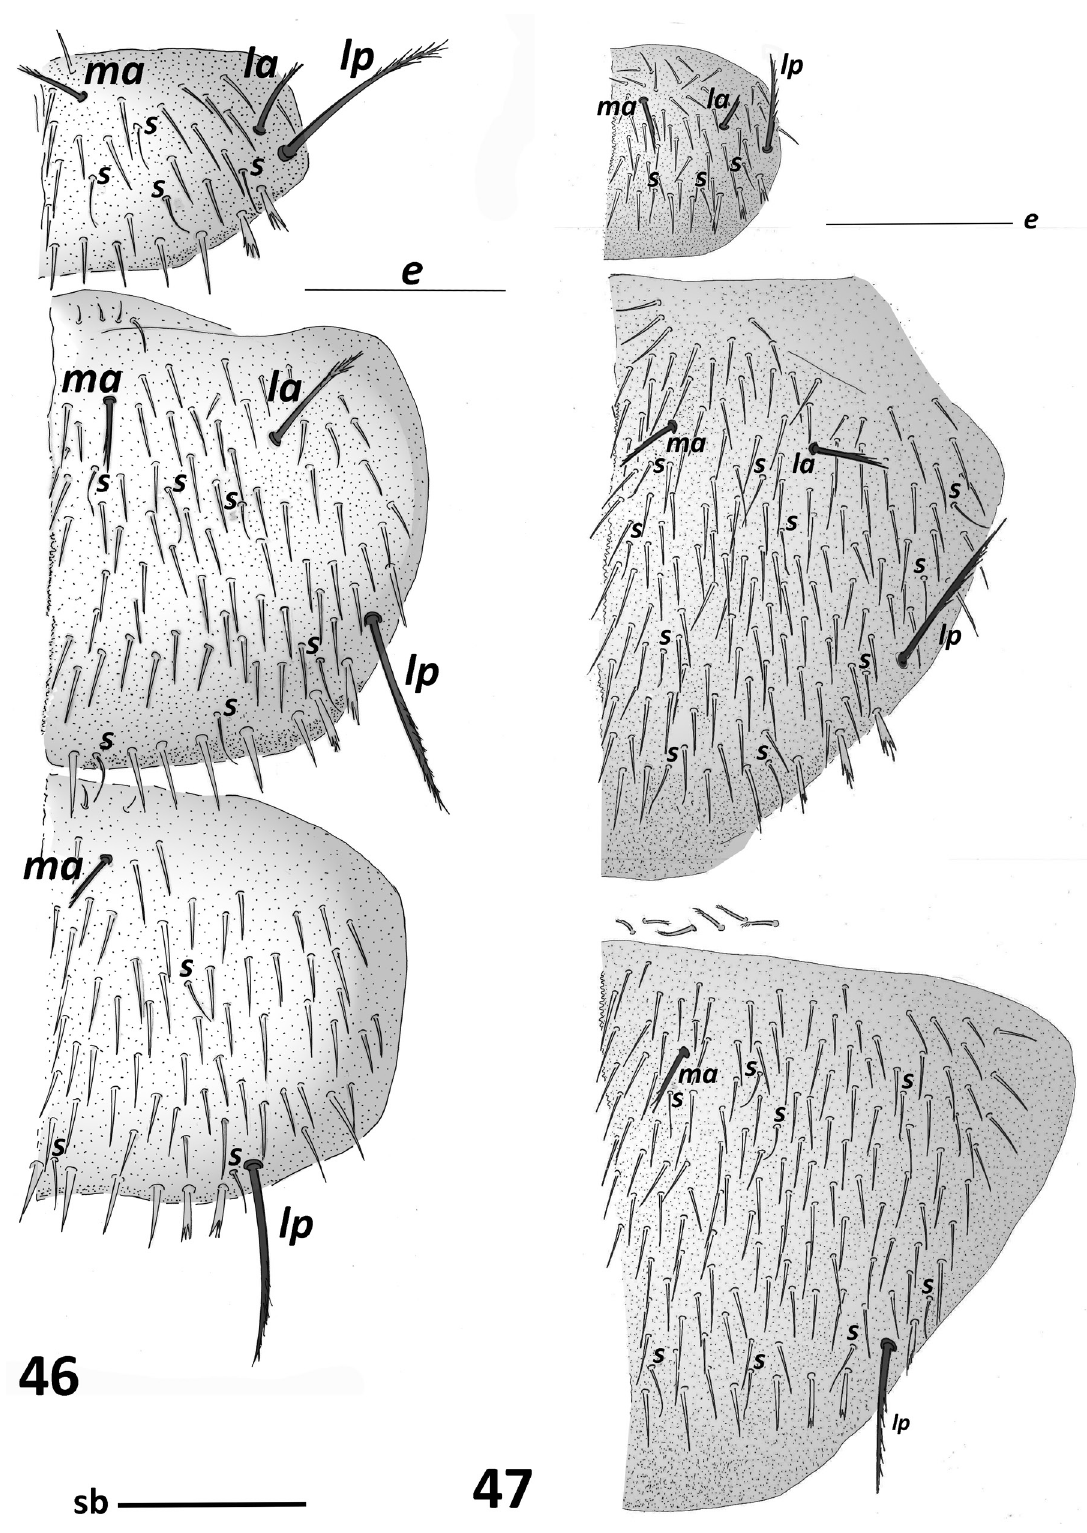
Figs 46–47. – 46 . Campodra ( Campodea ) plusiochaeta Silvestri, 1912, ♀, 3.8 mm, from Geneva, Switzerland, pronotum, mesonotum and metanotum. – 47 . Campodea ( Campodea ) pseudofragilis Condé, 1984, ♀, 3.7 mm, from Agigea, Romania, pronotum, mesonotum and metanotum. Abbreviations: see Material and methods. Scale bar: 0.1